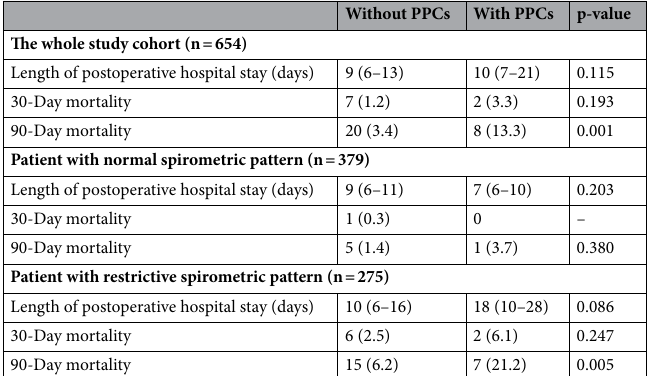
Without PPCs With PPCs